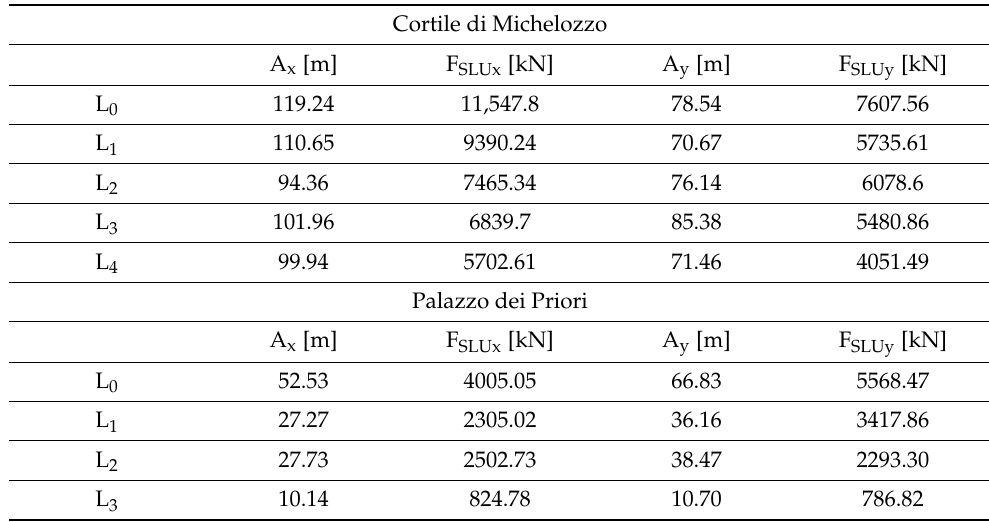
Table 3. Site geotechnical data for subsoil of the Arnolfo’s